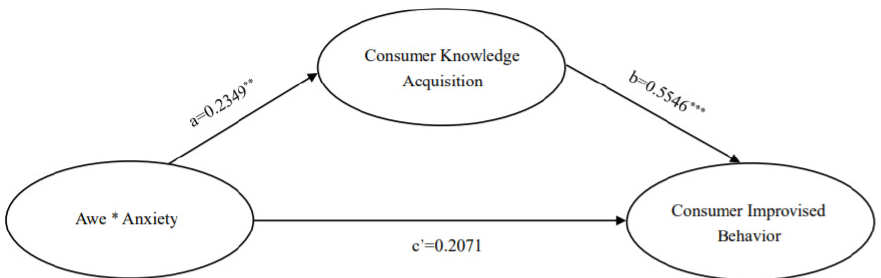
Figure 5. Results of the analysis of mediating effects of consumer knowledge ac-quisition (Looseness culture). Note: Awe * Anxiety represents the interaction of the two variables of awe and anxiety; ** indicates p < 0.01; *** indicates p < 0.001.